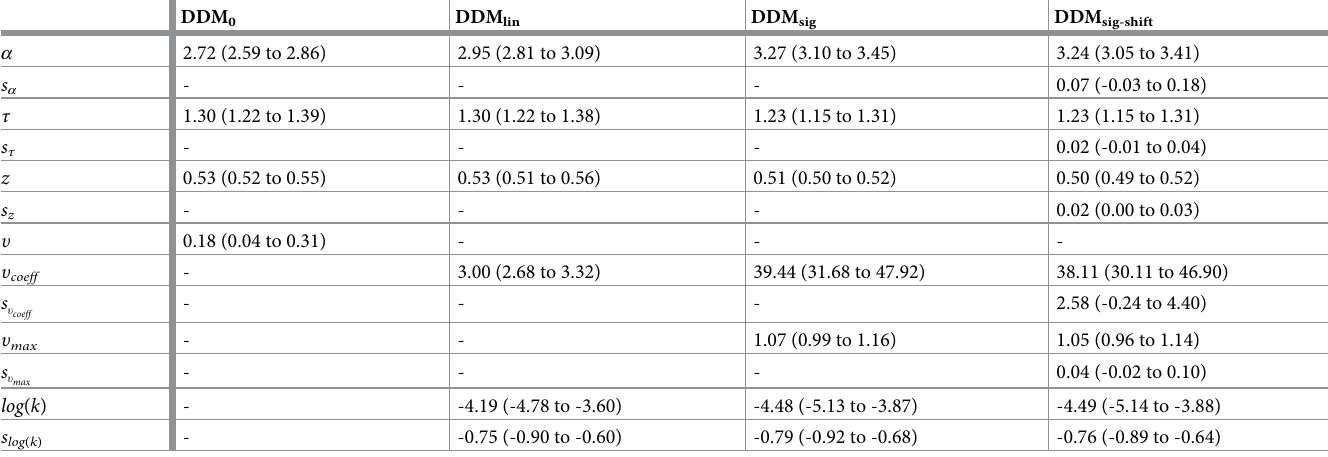
Table 5. Parameter group means and 95% HDIs of the posterior distributions of the drift diffusion models using normalised values. DDM